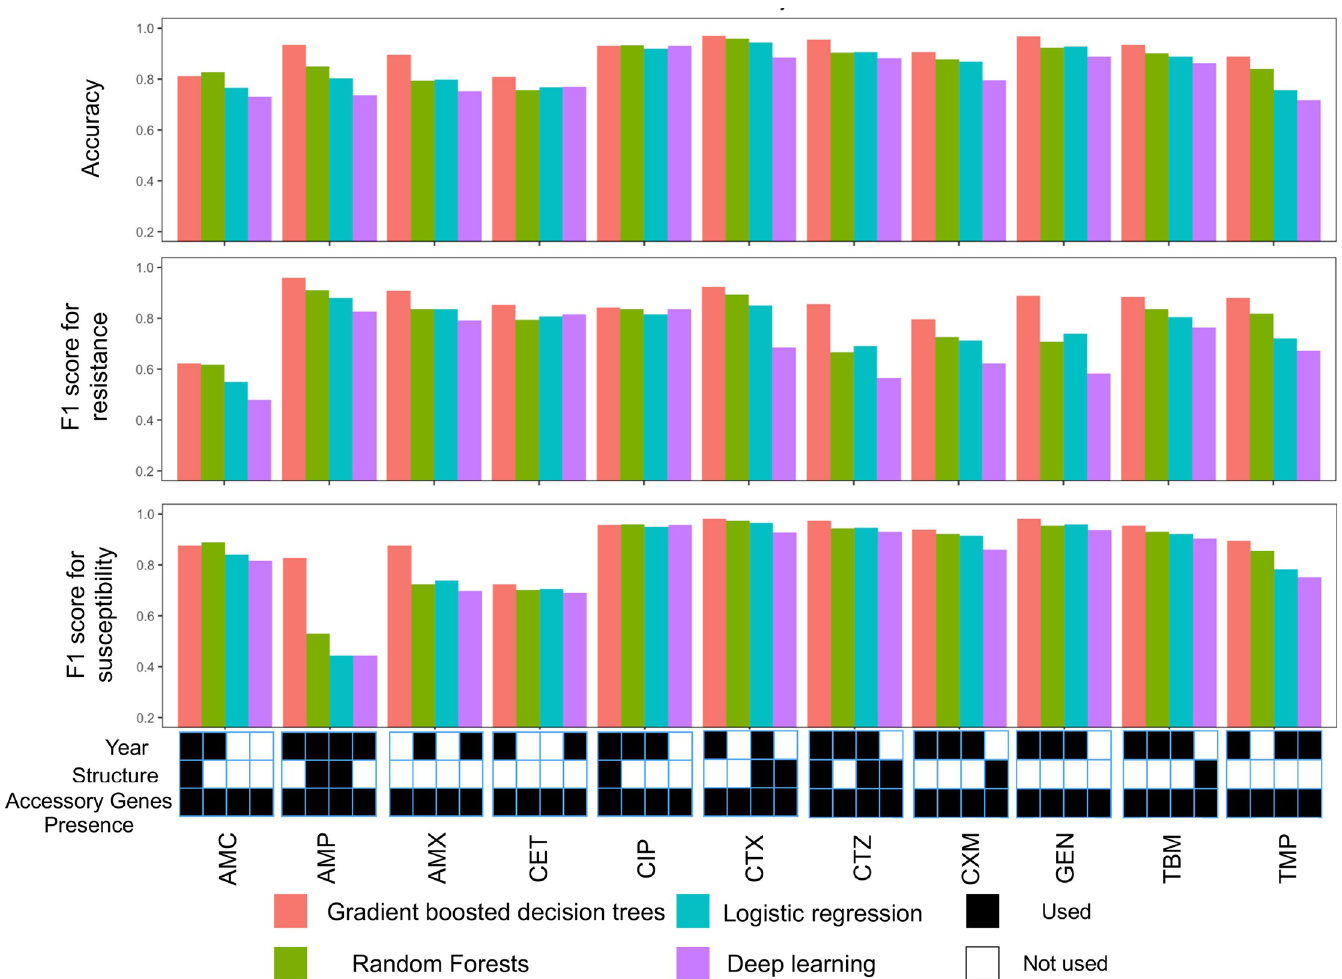
Fig 1. Prediction performance of the best tuned models. Accuracy and F1 score (harmonic mean of precision and recall; y-axis) for resistant (top panel) and susceptible (middle panel) phenotypes for four predictive models (red: gradient boosted decision trees; green: logistic regression; teal: random forests; purple: deep learning) across eleven antibiotics (x-axis). The best model of each class for every drug (x-axis) was identified based on the accuracy for predicting resistance and employed a number of possible combinations of gene presence, population structure, and year of isolation (lower panel; black: feature used; white: feature not used).